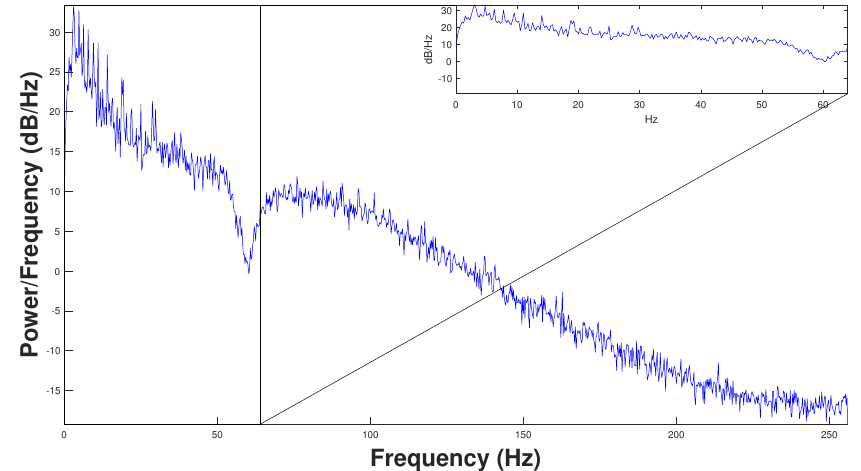
Figure 15. Power analysis or Periodogram of an EEG signal by means of the Fast Fourier